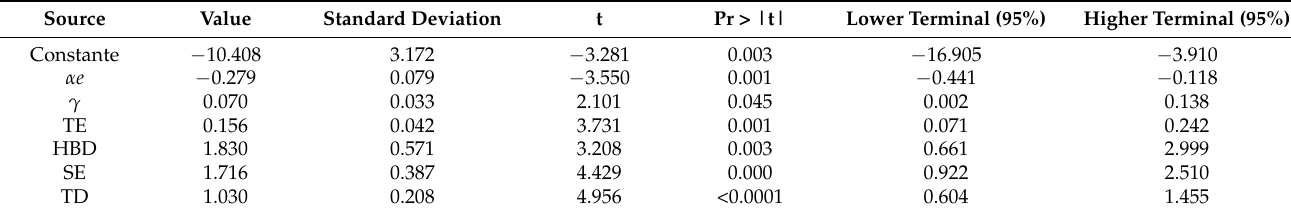
Table 2. Significance test of the